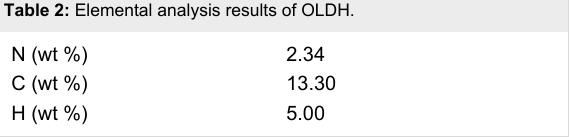
Table 2: Elemental analysis results of OLDH.